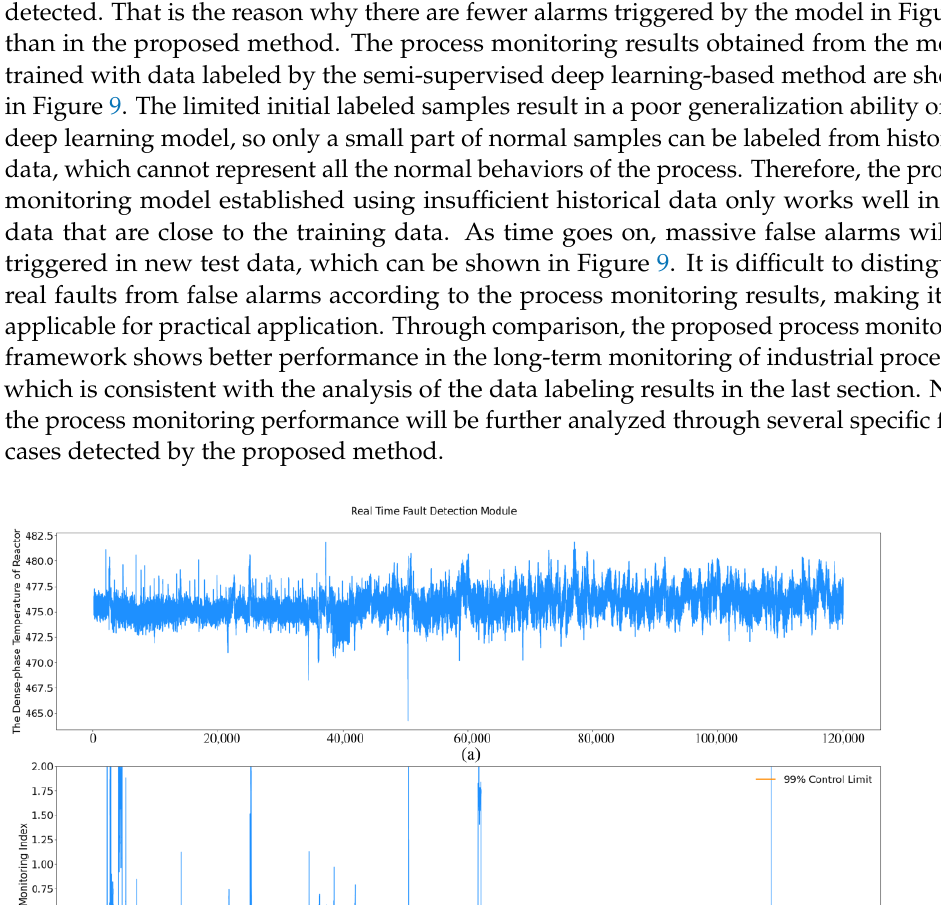
Figure 9. Three-month online process monitoring results (the model is trained with data labeled by semi-supervised deep learning-based method): (a) Original data of the key variable; (b) Fault detec- tion results.